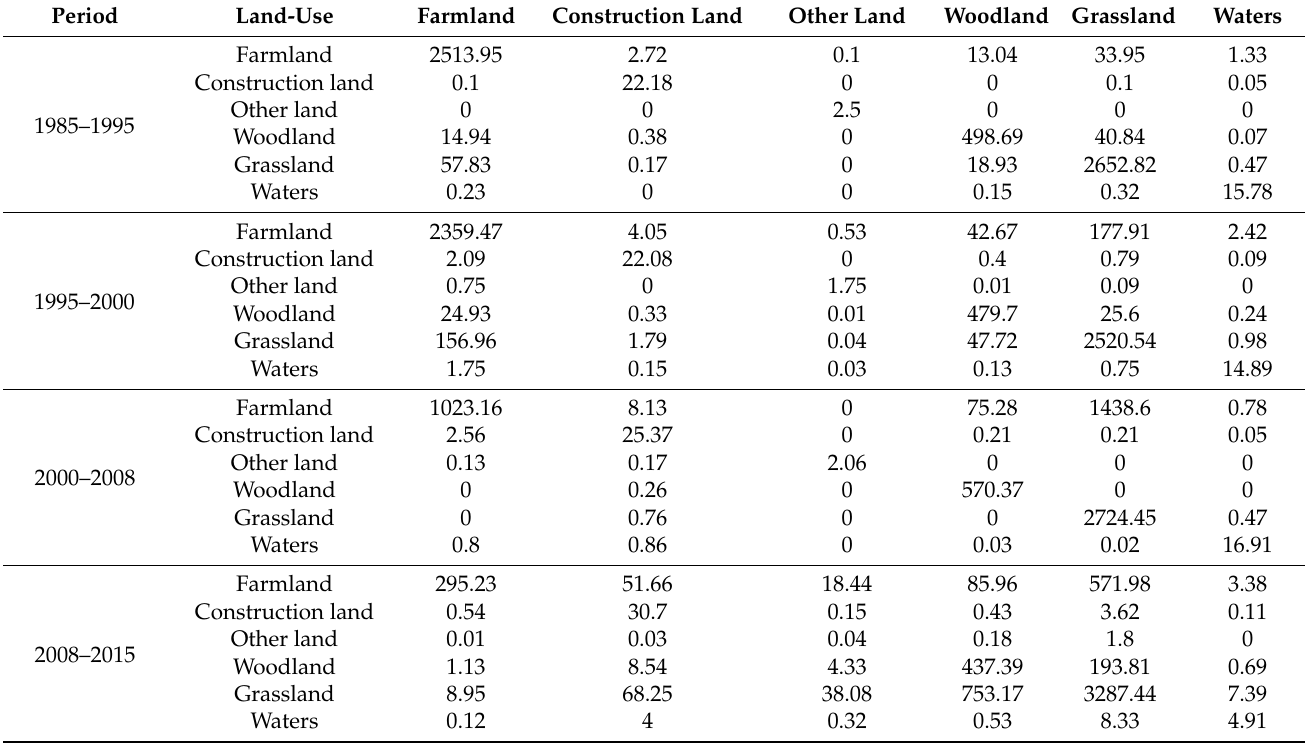
Table 3. Land-use transfer matrix from 1985 to 2015 (km 2 ).